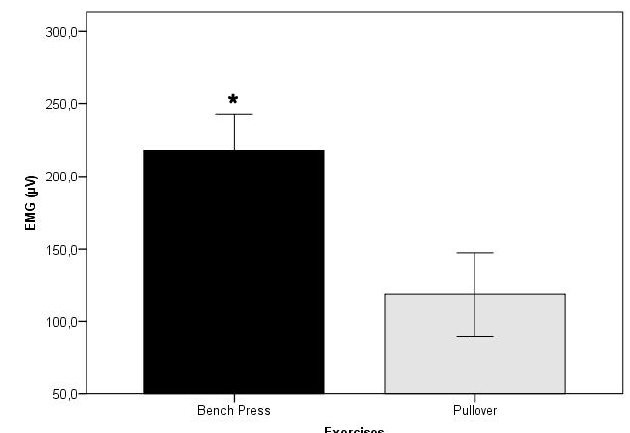
HBPFigure 1. Comparison of electromyographic activation of the major pectoral clavicular portion between horizontal bench press and barbell pullover exercises (mean and SD). # p < 0.05 - significant